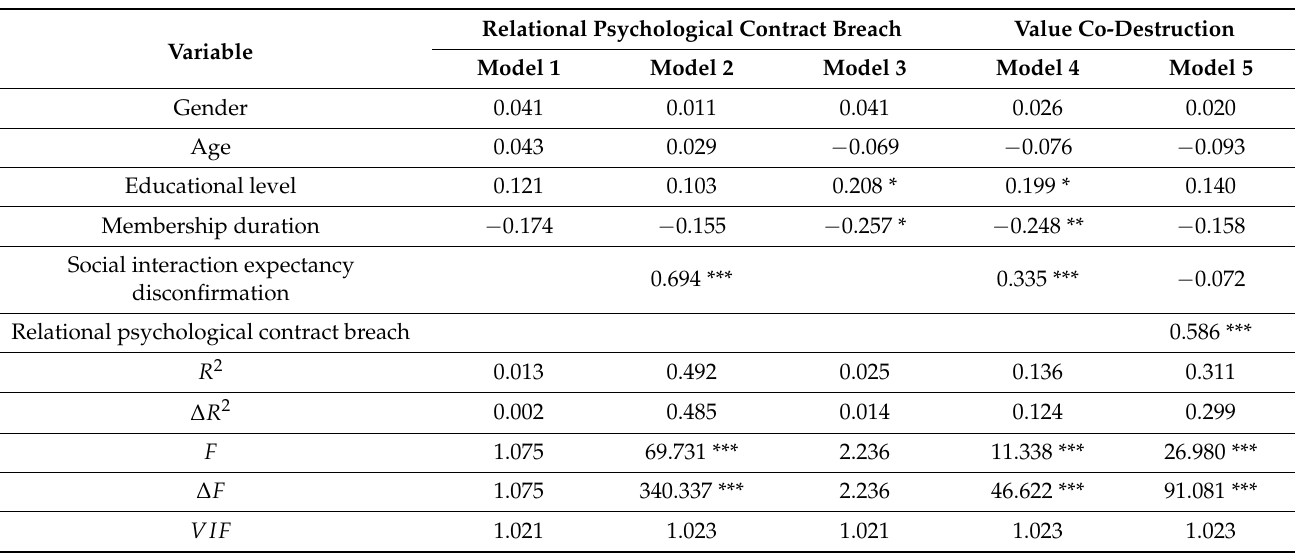
Table 7. Direct effect of social interaction expectancy disconfirmation and mediating effect of rela- tional psychological contract breach on value co-destruction.